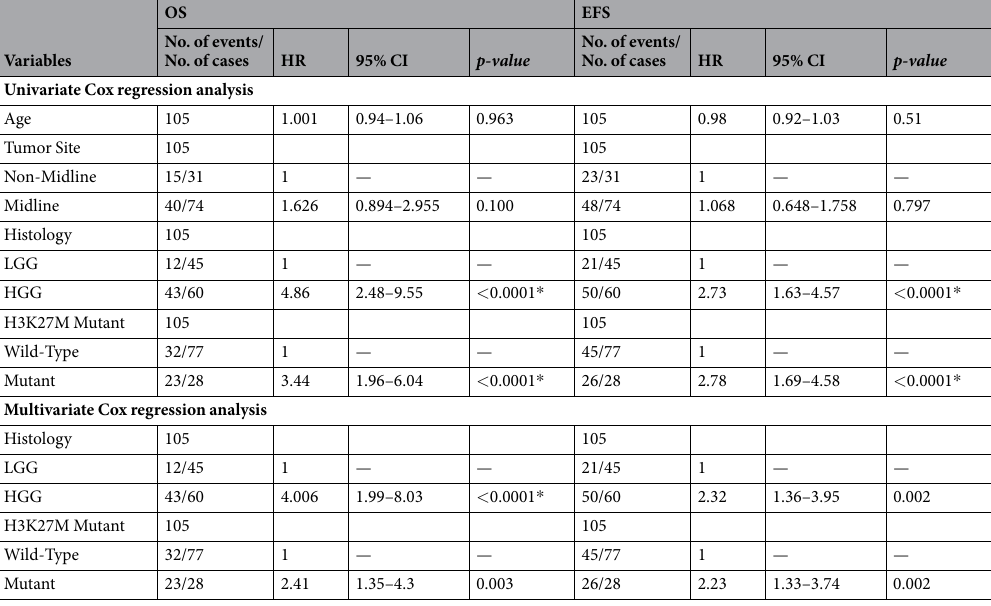
Table 2. Univariate and multivariate Cox regression analysis. Estimated hazard ratio for overall and event- free survival with 95% confidence interval and p-value of the likelihood ratio test. Abbreviations: OS = overall survival. EFS = Event- free survival. HR = hazard ratio, CI = confidence